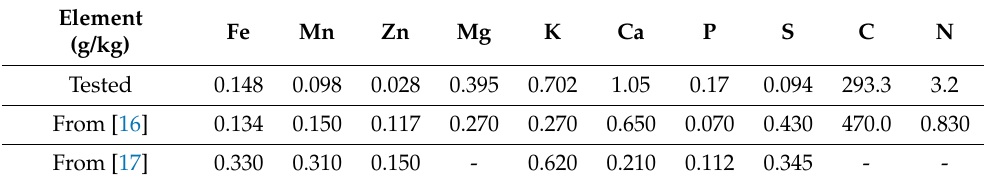
Table 1. Some elements detected in sawdust after drying